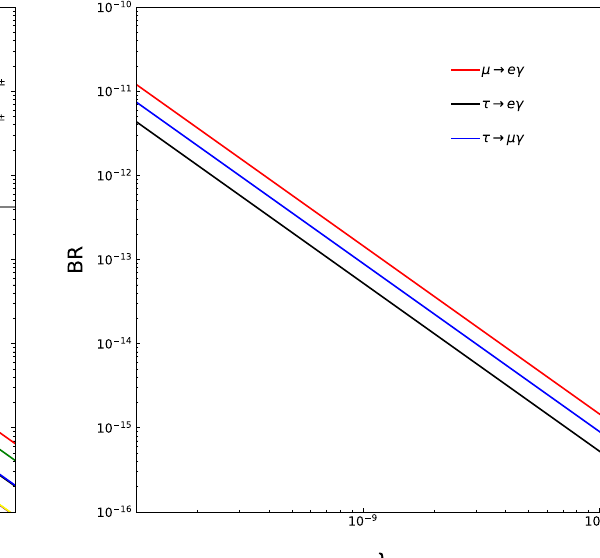
the sign. The black line for W ± is hidden under the blue line and the purple line is under the yellow one. The horizontal black line shows the experimental upper limit on the branching ratio. Right: Branching ratiosforthethreedecays μ → e γ (red), τ → e γ (black),and τ → μγ (blue) as function of λ X